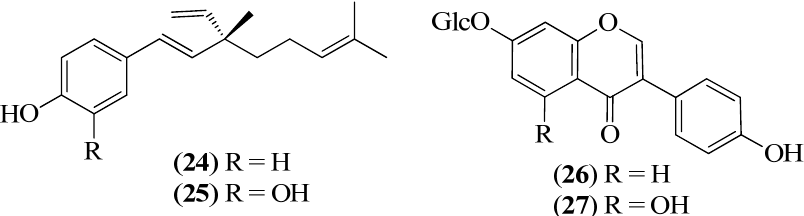
Figure 5. Structures of compounds 24 – 27 from Otholobium mexicanum .